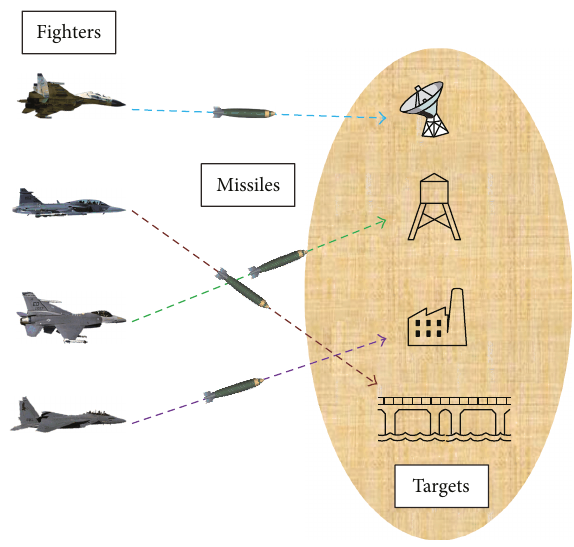
Figure 1: Illustration of the WTA